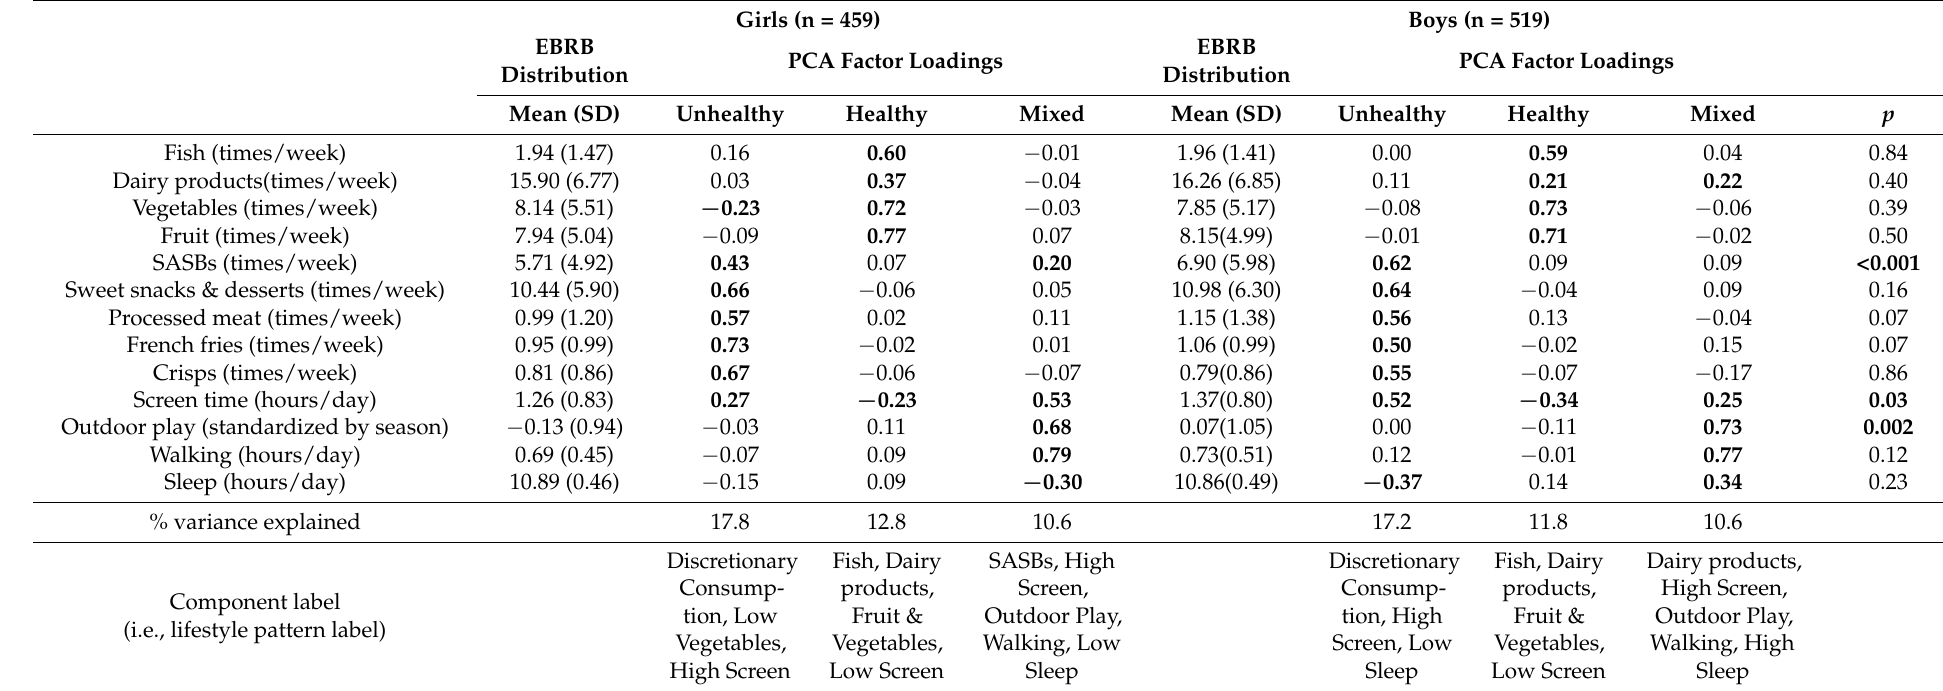
Table 2. EBRB distribution and PCA factor loadings for lifestyle patterns at year 5. The EDEN